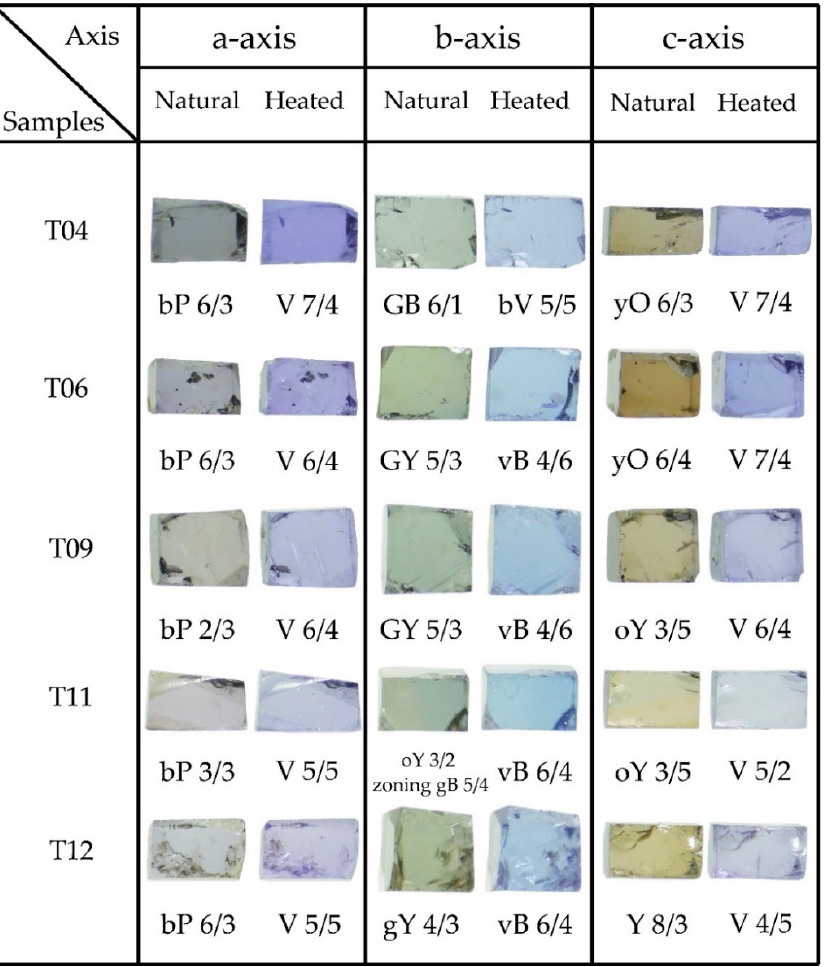
Figure 3. All tanzanite samples show natural trichroic colors including purple, green, and yellow dominating along the directions of a-, b-, and c-axes, respectively, as suggested by [3,13,14,17]; they turned to dichroic coloration between violet color (along the a- and c-axes) and blue color (along the b-axis) after the heating experiment.